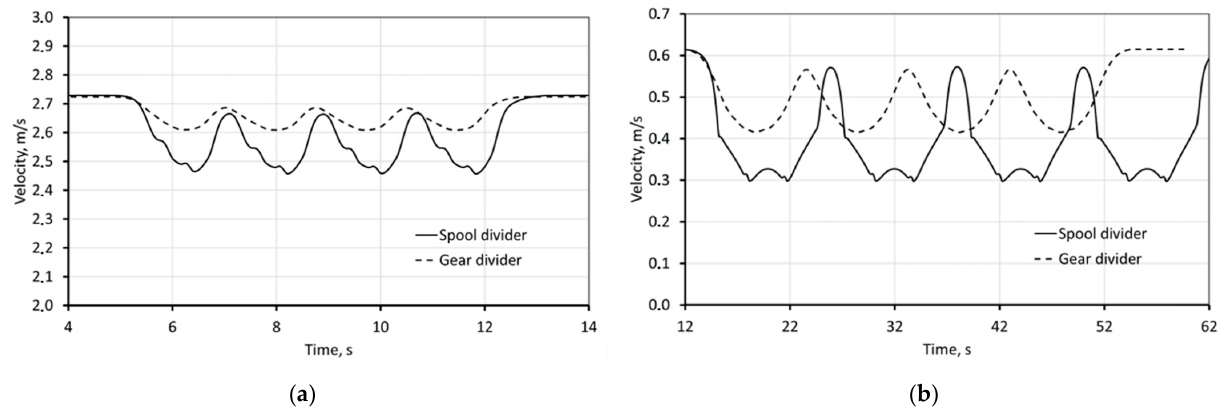
Figure 13. Vehicle velocity with nominal pump flow ( a ) and 25% of nominal pump flow ( b ) for model with spool and gear flow dividers.